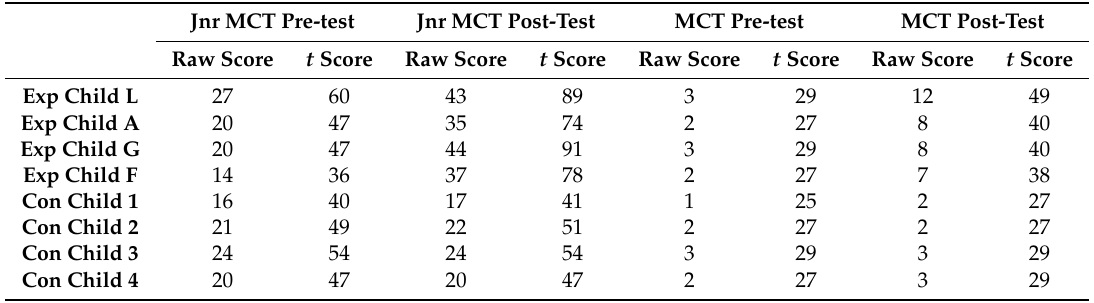
Table 5. Raw and t scores at the Jnr MCT and MCT, pre- and post-test. Experimental and control groups.